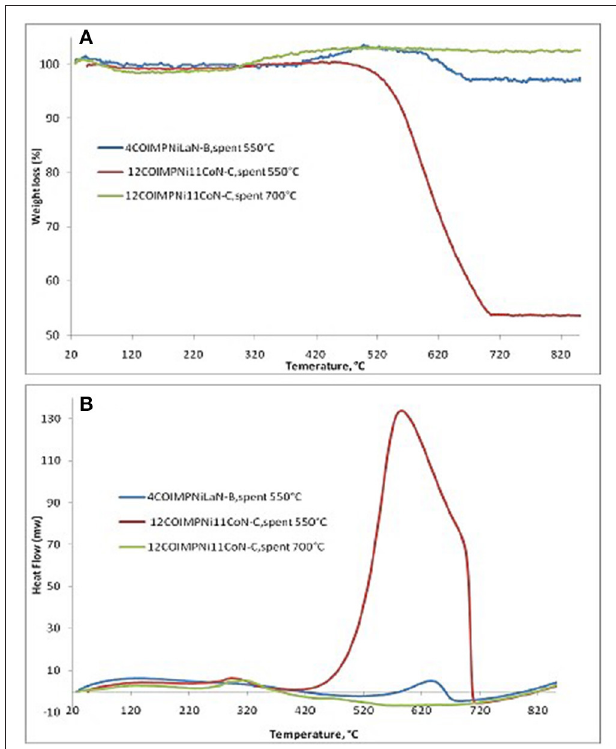
FIGURE 9 | TGA (A) and DSC (B) analysis of 12COIMPNi11CoN-C and 4COIMPNi12LaN-B spent